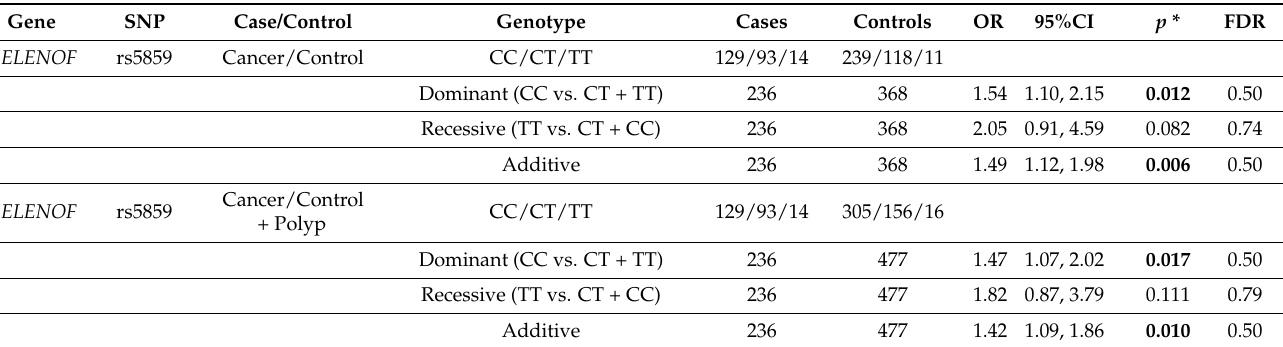
Table 3. The significant associations between SNPs and colorectal neoplasia risk for different subsets of the stratified analysis in the Irish